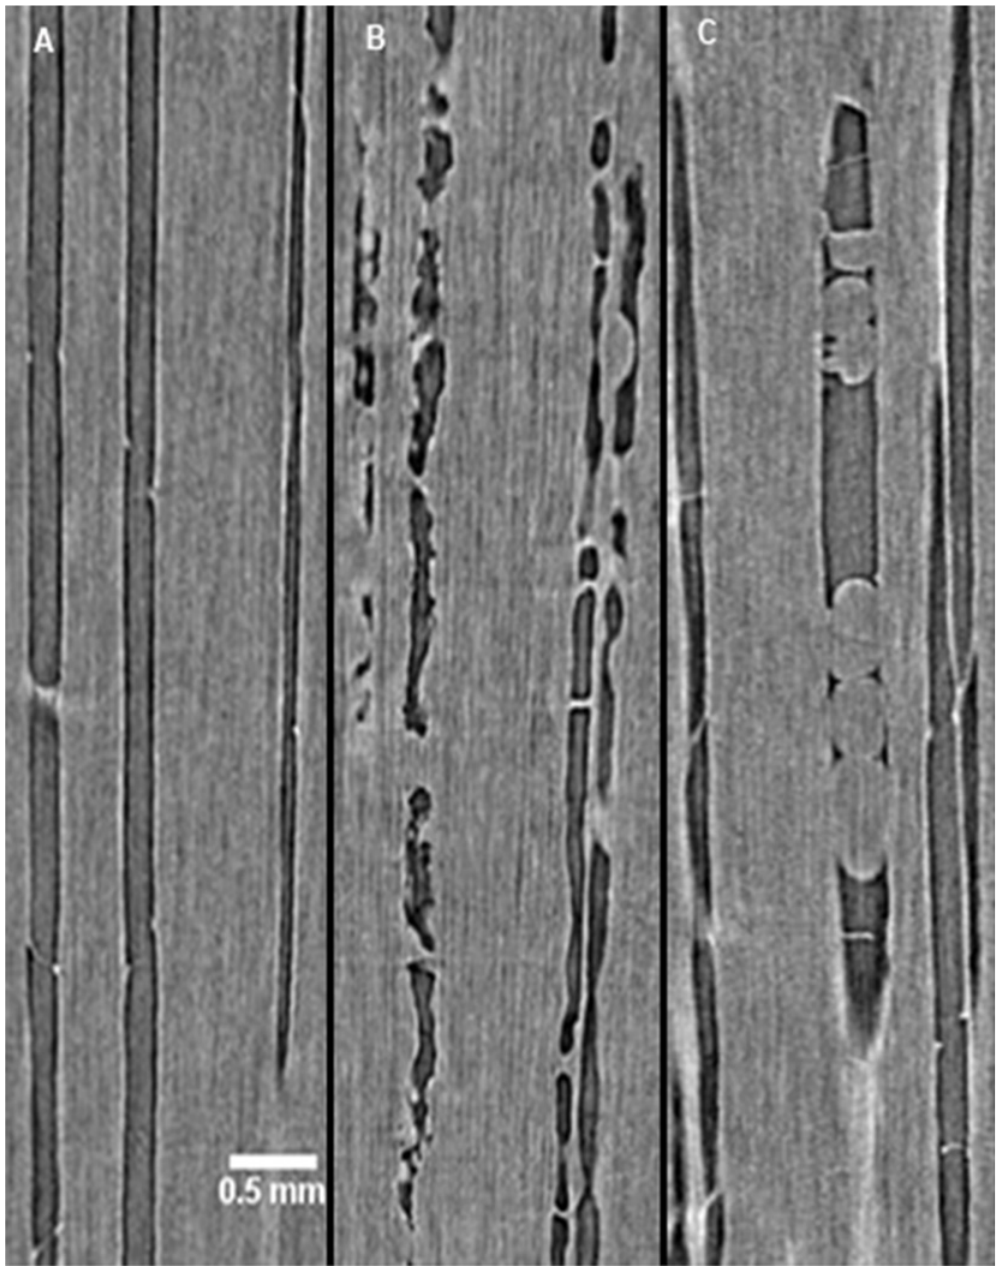
Fig 3. HRCT distinguished gel and tyloses-occluded xylem vessels. Shown here are optical sections of plants representative of three treatment-time combinations. (A) NINW-0 MPI, with unoccluded vessels. (B) IW-2 MPI, with gel-occluded vessels. (C) NIW-2 MPI, with tyloses-occluded vessels. Three- dimensional projections from which these optical sections originated are shown in S1